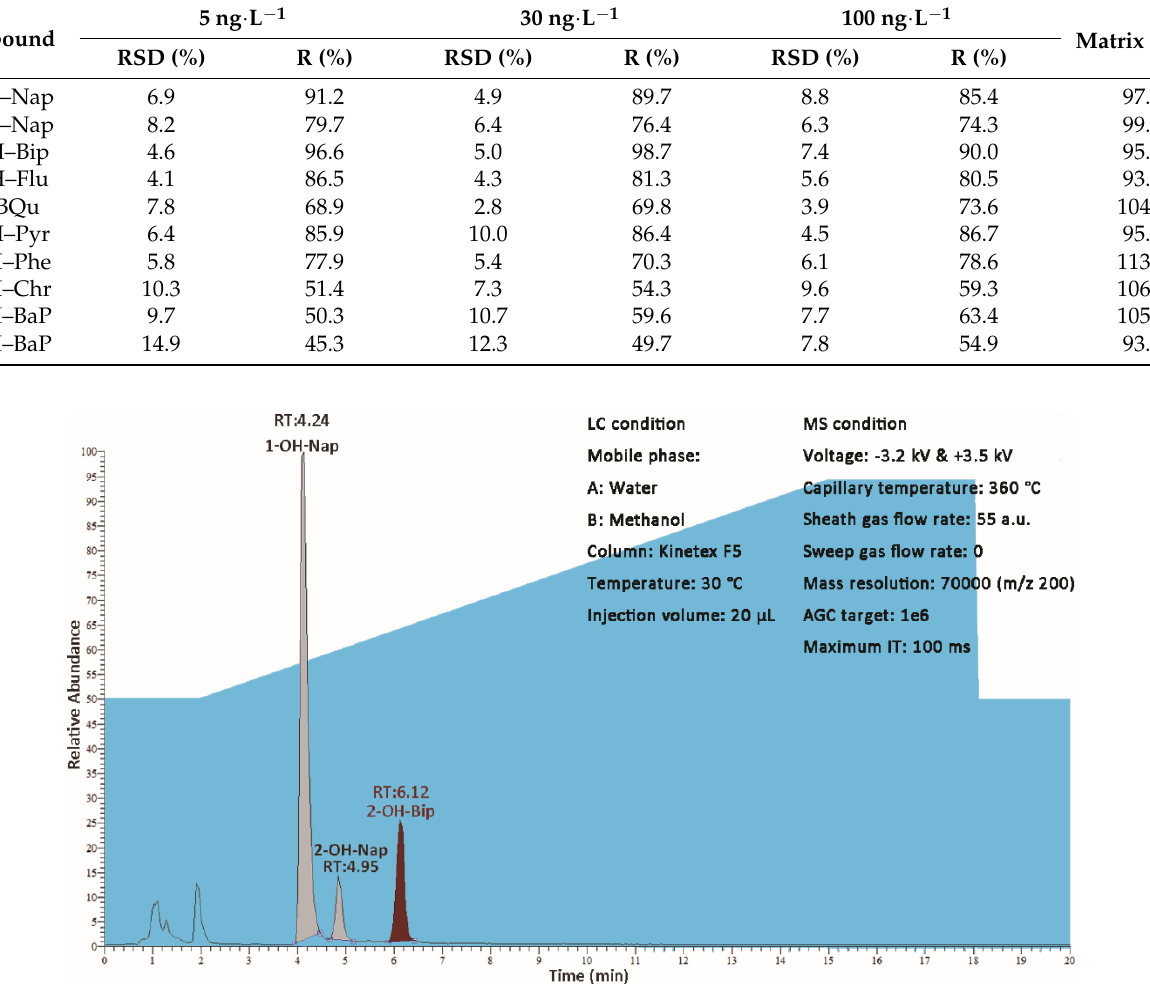
Table 4. RSD ( n = 7) and recovery (R) of extraction at different concentrations and matrix effects.